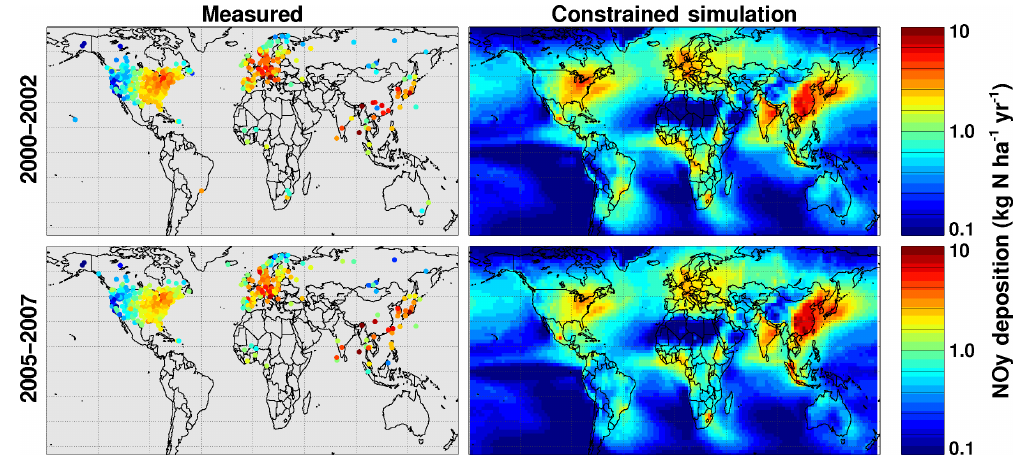
Figure 2. Annual wet NO − deposition from measurements available through the World Data Centre for Precipitation Chemistry and from 3 the GEOS-Chem simulation constrained with satellite observations of NO 2 . Two time periods are represented: 2000–2002 and 2005–2007.